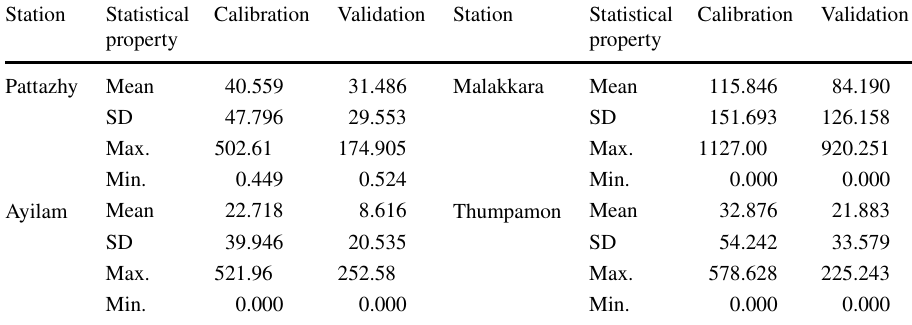
Min. minimum, Max maximum, SD